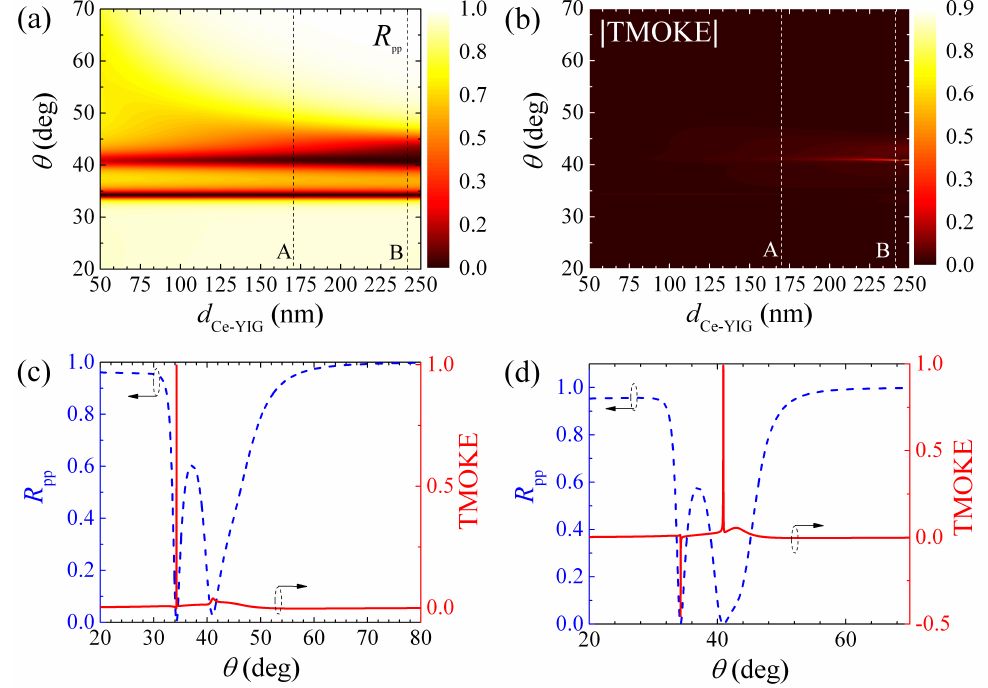
Figure 5. ( a ) Reflectance R pp for m = 0 (i.e., the demagnetized system) and ( b ) | TMOKE | as functions of the incident angle ( θ ) and the MO layer thickness ( d Ce − YIG ) for the system with d m = 28 nm and d d = 50 nm. The vertical dotted lines (labeled A and B ) in ( a , b ) denote results for d Ce − YIG = 170 nm and d Ce − YIG = 242 nm, which are plotted in ( c , d ),